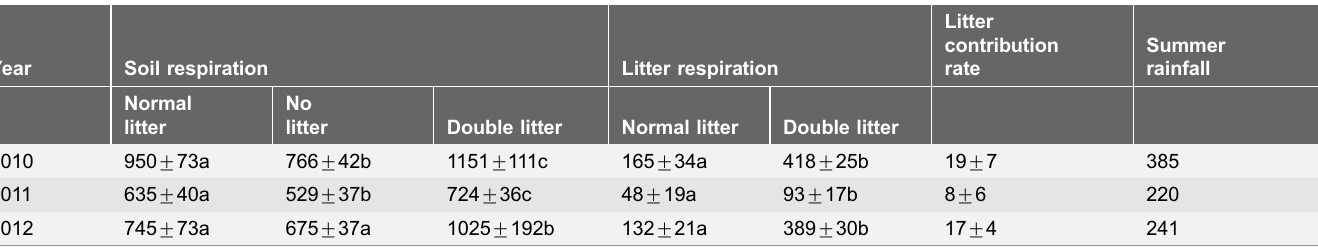
Table 1. Annual soil respiration (g C m 2 2 y 2 1 ), annual litter respiration (g C m 2 2 y 2 1 ), annual litter contribution rate (%), and summer rainfall (mm) from 2010 to